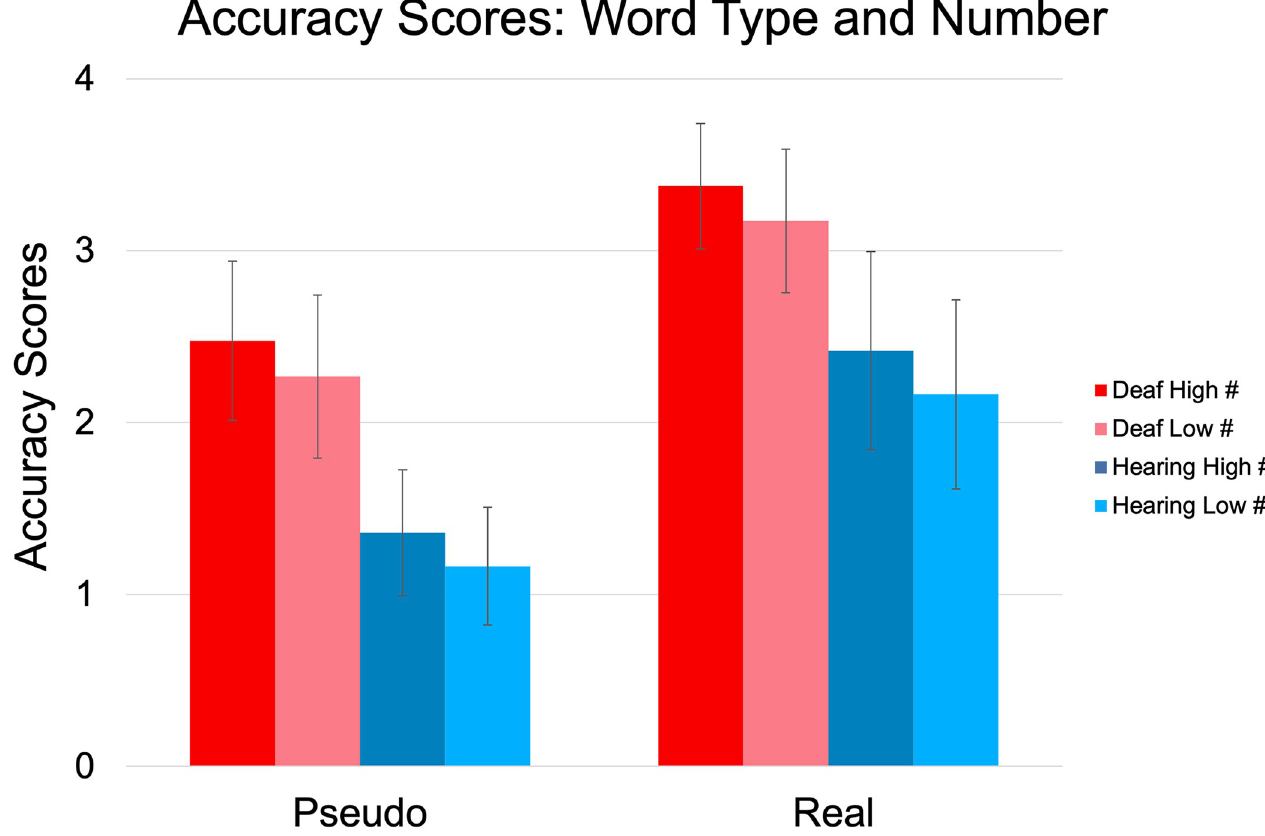
Fig 2. Average accuracy of responses to pseudo and real location names between groups. Error bars show standard deviation. Accuracy is shown based on reliable coding of typed responses (0 = entirely wrong; 4 = correct).